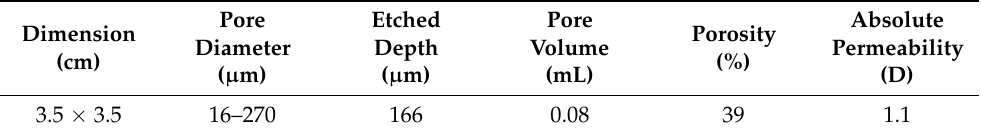
Table 3. Physical and petrophysical characteristics of the